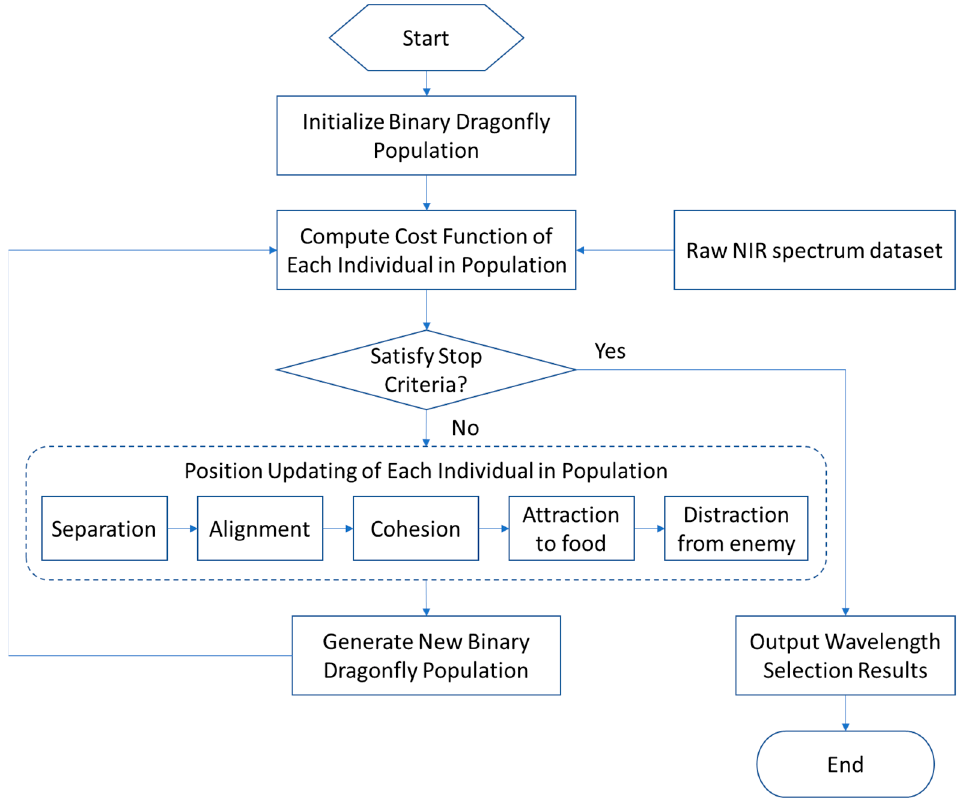
Figure 2. The flowchart of the binary dragonfly algorithm (BDA)-based wavelength selection method.